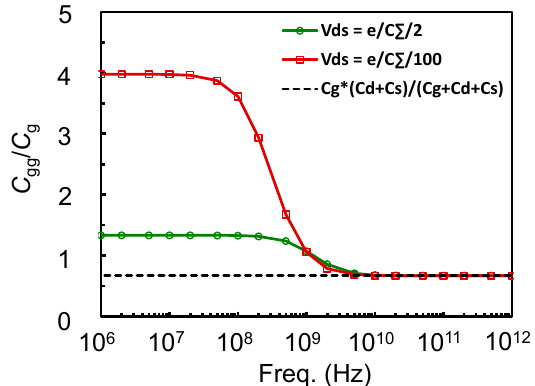
Figure 5. SET input capacitance C gg as a function of frequency at drain voltages V ds = 0.534 mV [0.01] and 26.7 mV [0.5], gate voltages V gs = 80.1 mV [0.5] and 93.5 mV [0.6] and T = 15.5 K [0.05].